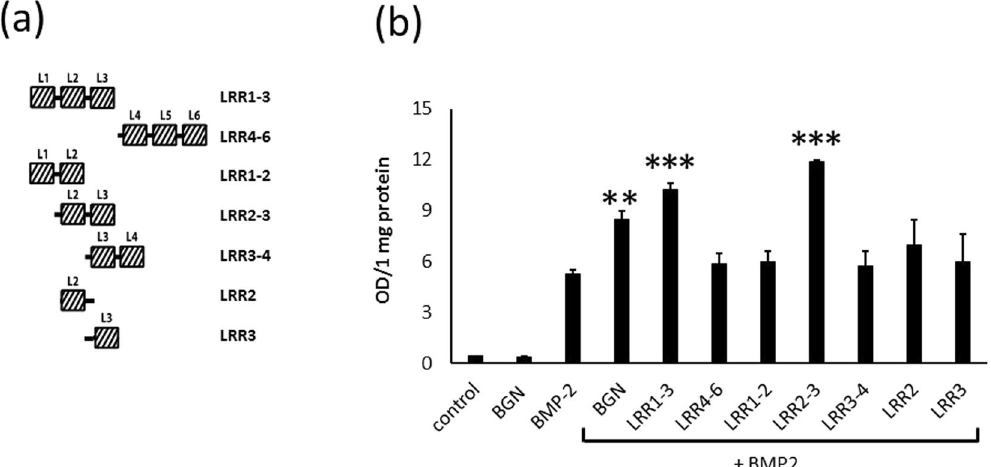
Figure 2. Synthetic peptides and its effect on ALP activity. ( a ) Schematic drawings of synthetic peptides derived from LRR 1–6 including LRR1-3, LRR4-6, LRR1-2, LRR2-3, LRR3-4, LRR2 (with a hinge) and LRR3 (with a hinge). ( b ) ALP activities in C2C12 cells. Note that the most significant effect was found in combination of BMP-2 with LRR2-3. Values are shown as mean ± S.E. (n = 3). ** p < 0.01, *** p <